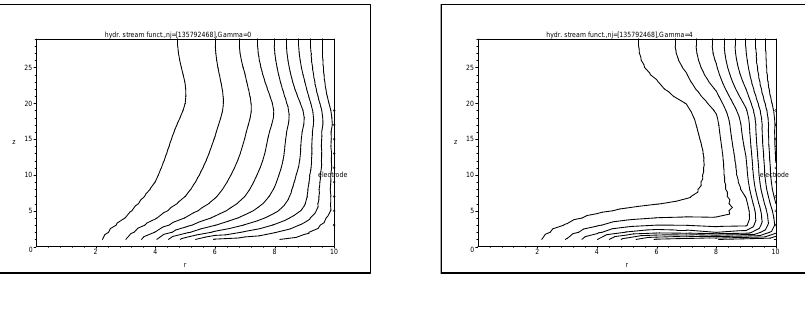
Figure 4. The stream functions for nj = [135792468] , ψ ∈ (0 . 00 , 0 . 16) , Γ = 4